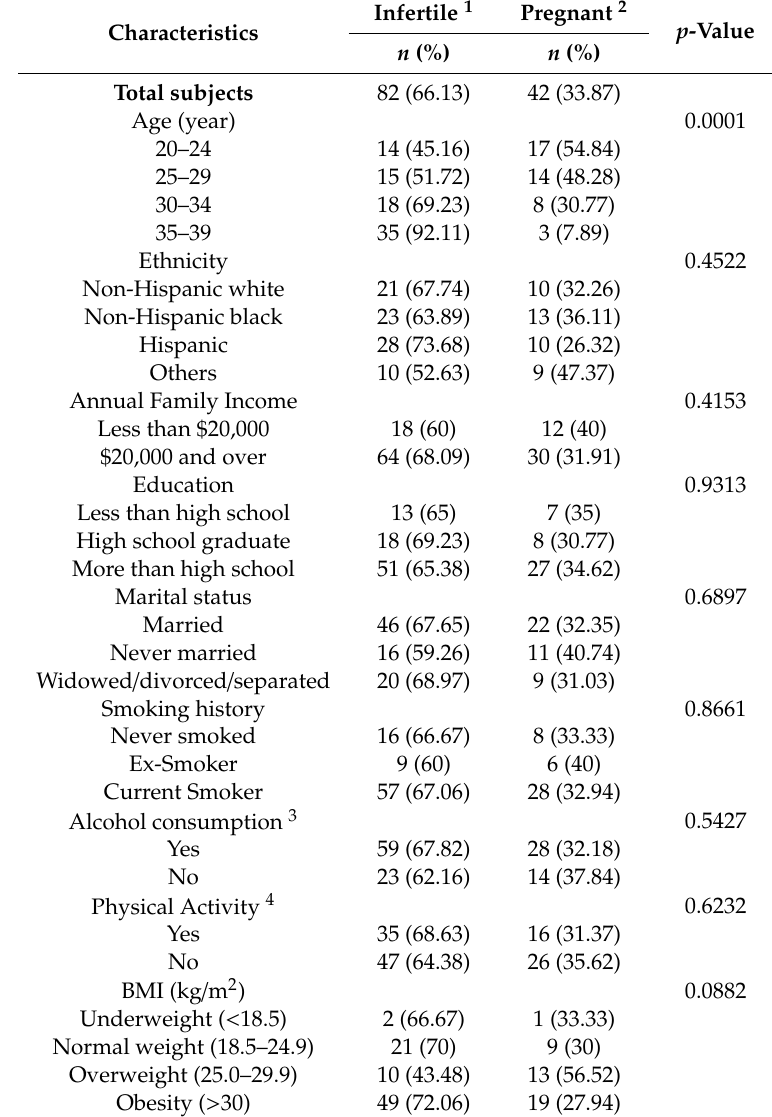
Table 1. Characteristics of the study population ( n =